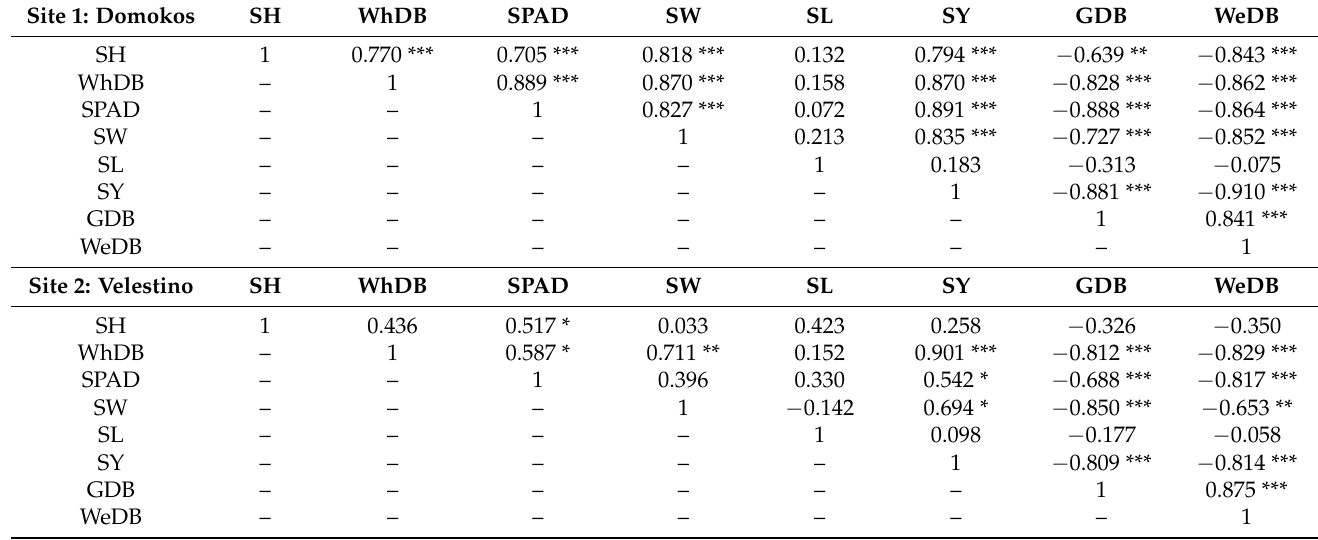
Table 1. Pearson’s correlation coefficients (r) for plant height (PH), durum wheat dry biomass (WhDB), relative chlorophyll content (SPAD), 1000-seed weight (SW), spike length (SL), seed